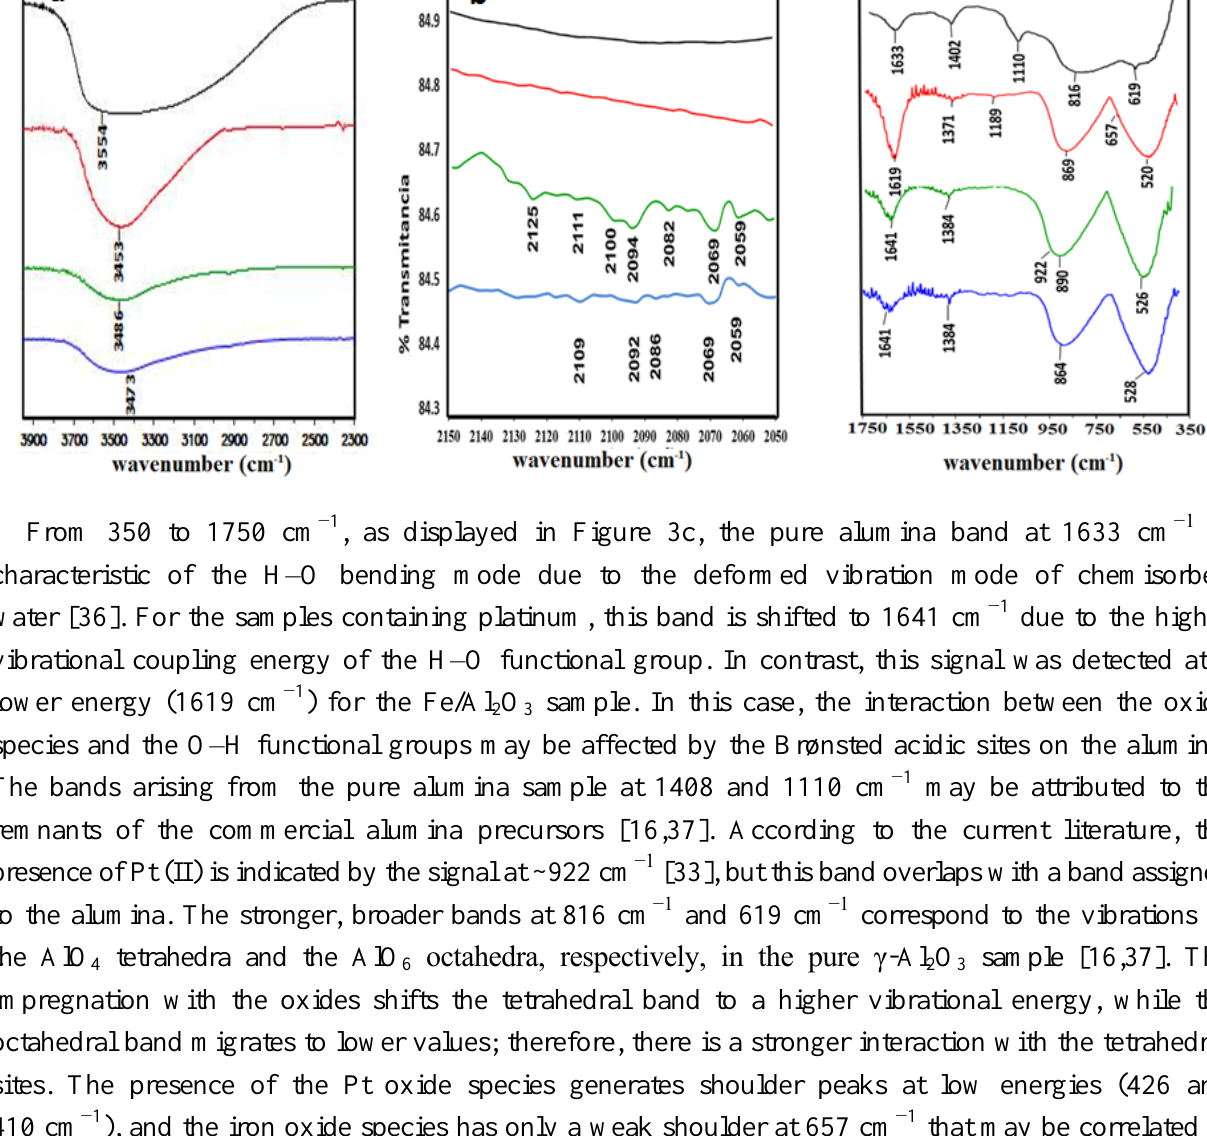
O 0.5% (—), Pt/Al 2 3